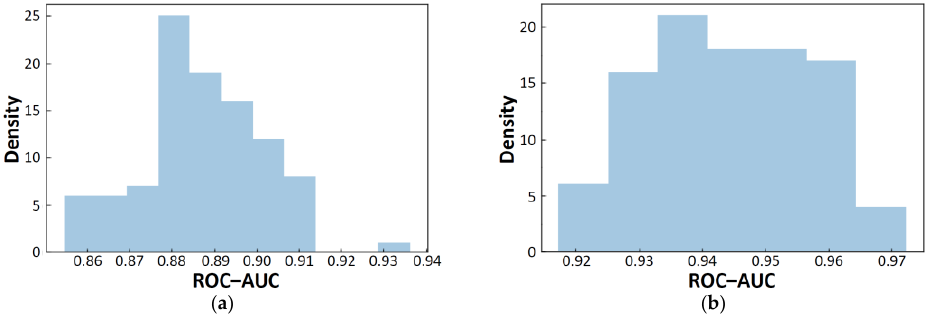
Figure 12. Distributions of ROC-AUC scores for the the test set of 31 compounds ( a ) and for the the test set of 95 compounds ( b ).